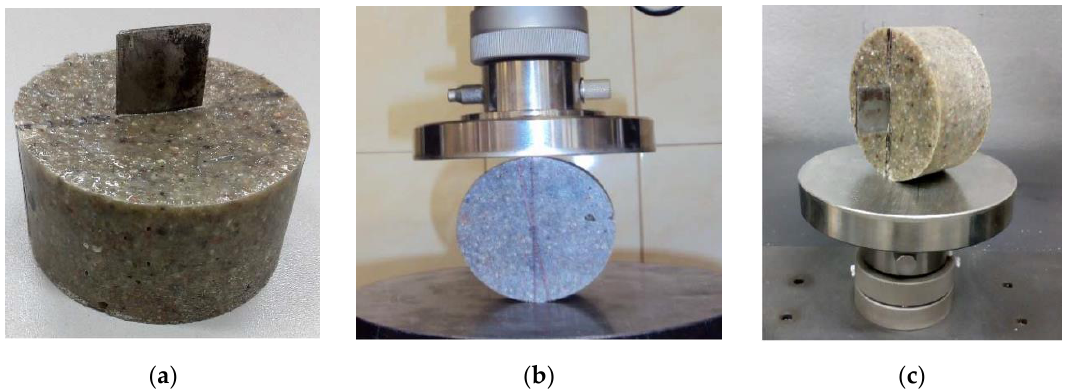
Figure 3. Sample for testing brittle fracture toughness: ( a ) before testing; ( b ) in the testing machine; ( c ) after the test.